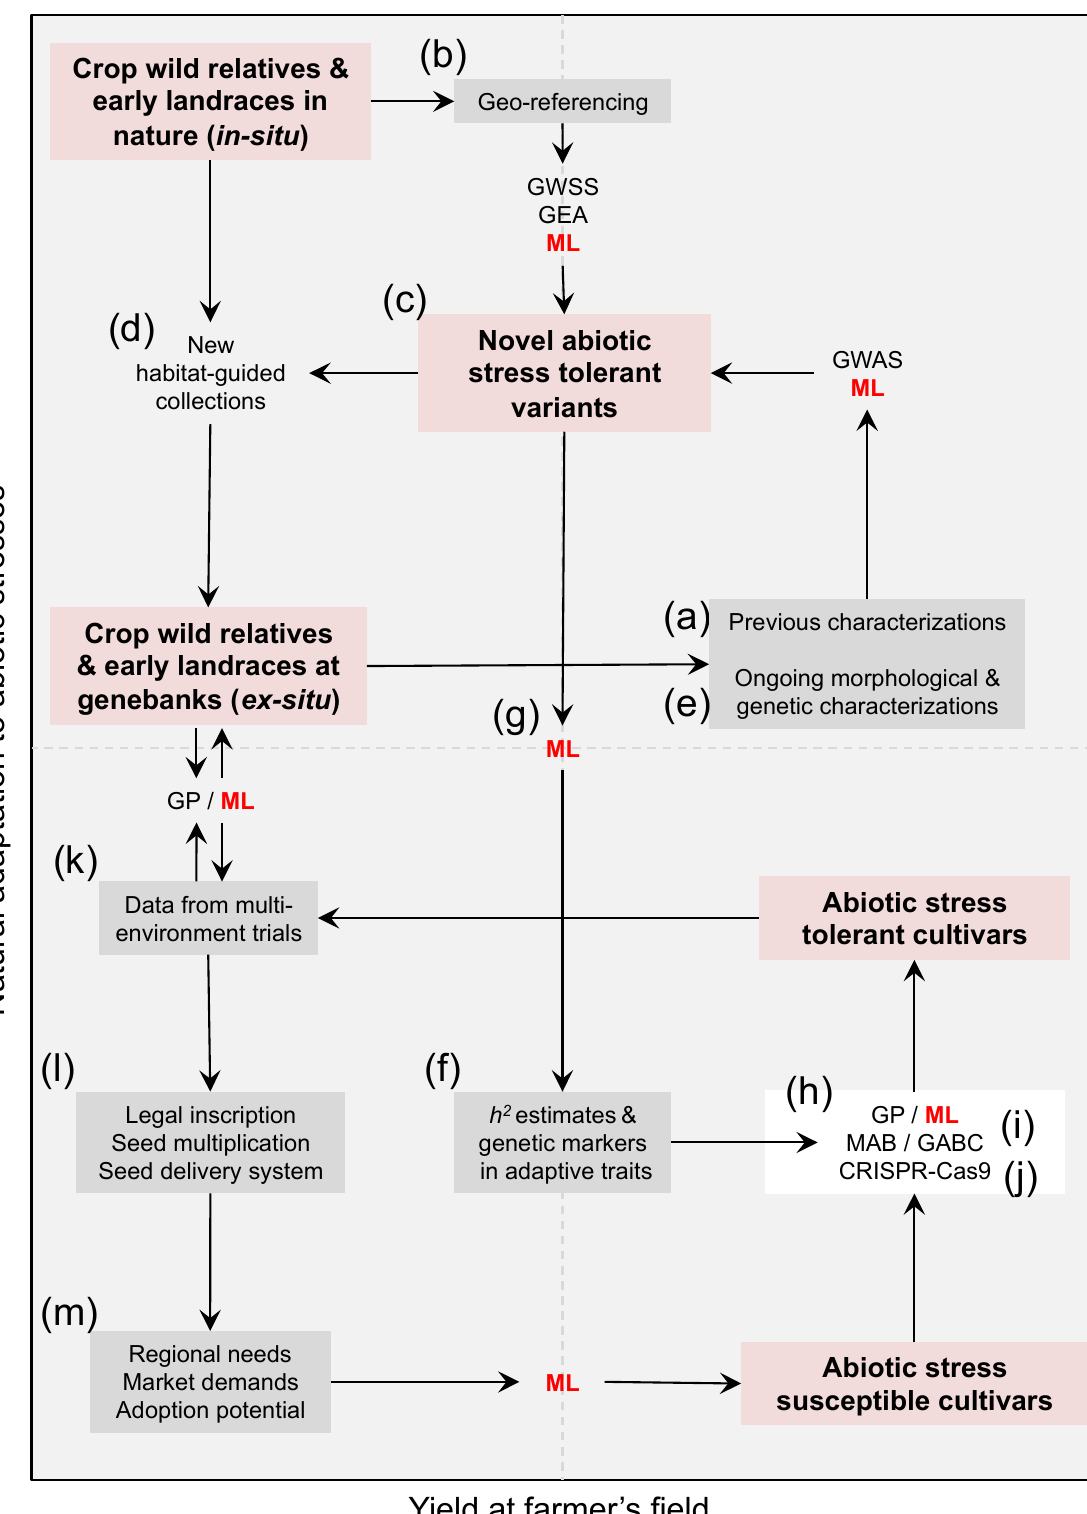
Figure 1. A roadmap of trans-disciplinary approaches aiming at harnessing genebank utilization for climate change research in the face of heat, and water scarcity. Compiling ( a ) previous characterizations and ( b ) geo-referencing-derived climate data/indices of available genetic resources in genebanks is a starting point to ( c ) assess the extent of abiotic stress tolerance among existing accessions, and the need of ( d ) new habitat-based population-guided collections targeting isolated pockets of cryptic diversity in dry and semi-arid regions. Planning question-oriented collecting trips of crop wild relatives and